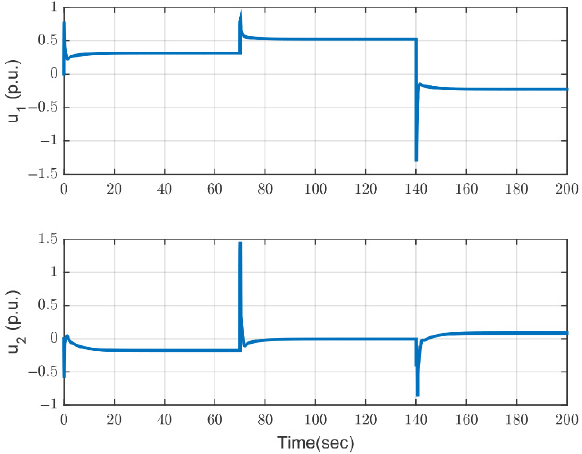
Figure 12. Tie-line power deviations of proposed LFC controller for the random step load disturbance.